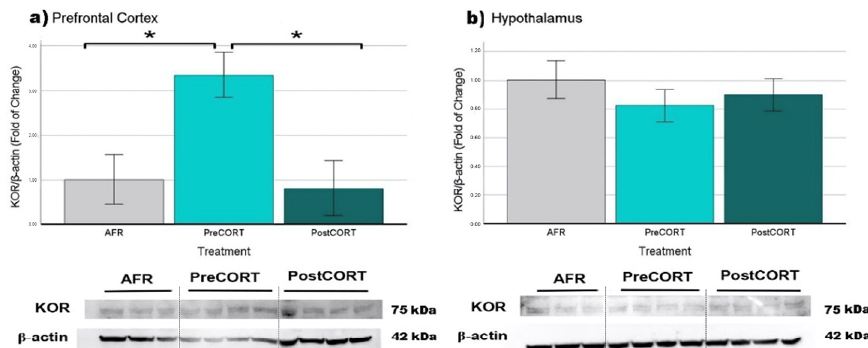
Figure 16. κ -Opioid Receptors (KOR) expression. Histograms and representative bands of KOR expression in ( a ) prefrontal cortex and ( b ) hypothalamus in AFR ( n = 5, prefrontal cortex; n = 6, hypothalamus); PreCORT ( n = 6, prefrontal cortex; n = 8, hypothalamus) and PostCORT subjects ( n = 4, prefrontal cortex; n = 8, hypothalamus). Each lane corresponds to different mice. Data are presented as mean ± SEM (* p < 0.05).